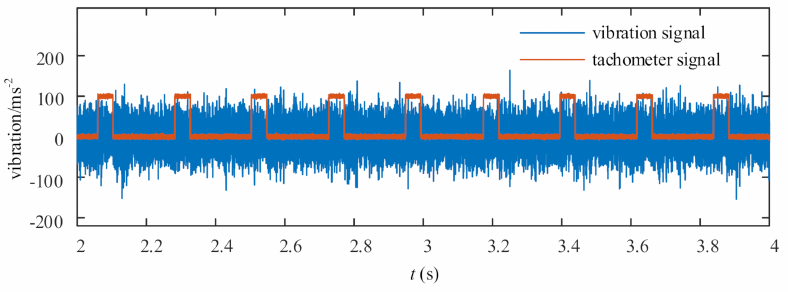
Figure 19. Laboratory experiment signal.